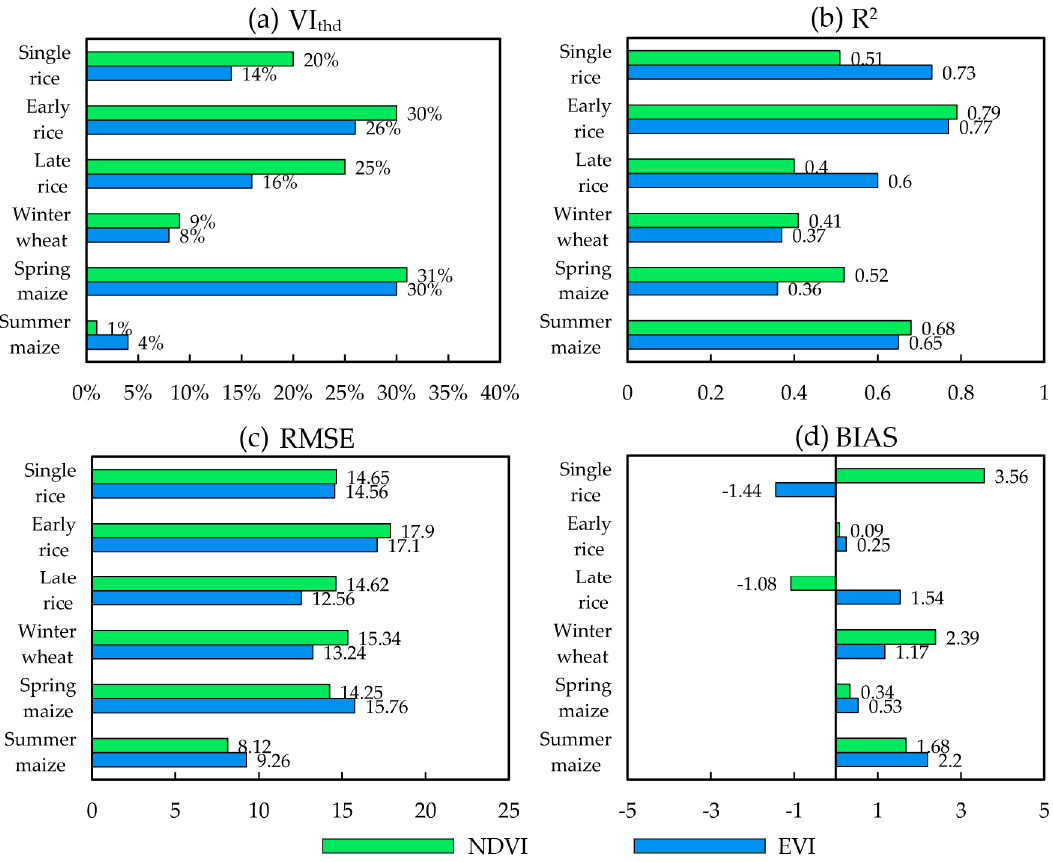
Figure 7. Optimal thresholds and corresponding accuracies of the retrieved the start of the season (SOS) based on Normalized Difference Vegetation Index (NDVI) (green) and Enhanced Vegetation Index (EVI) (blue). ( a ) The optimal threshold (VI thd ), ( b ) Coefficient of determination (R 2 ), ( c ) Root Mean Square Error (RMSE), ( d ) BIAS.